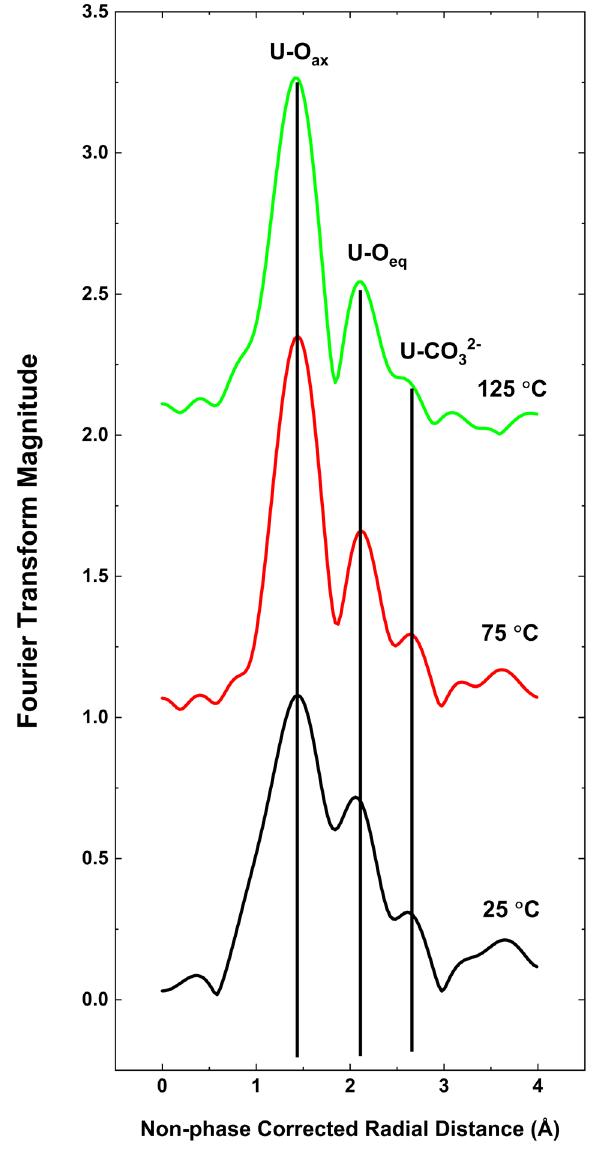
Fig. 2 Fourier transforms of EXAFS data collected for 0.25 m NaHCO 3 0.05 m UO 3 solution at 25, 75, and 125 °C. Note the diminishment, with increasing temperature, of the peak associated with the uranium-C single scattering path at ~2.6 Å and the peaks between 3 and 4 Å typically attributed to multiple scattering paths associated with the carbonate